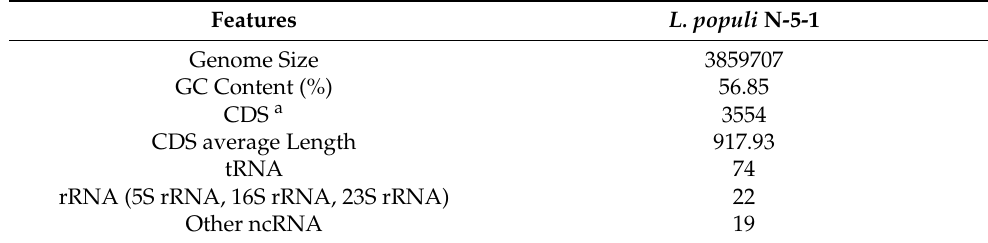
Table 1. Features of L. populi N-5-1 genome.